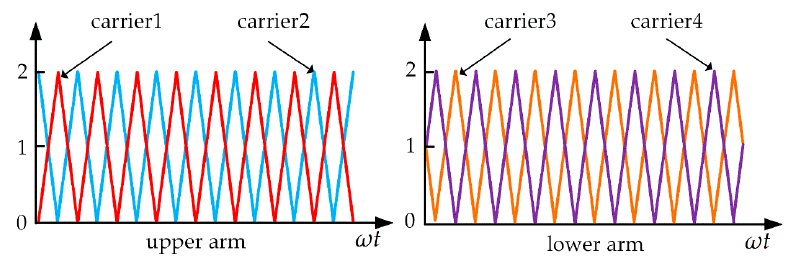
Figure 9. The carrier